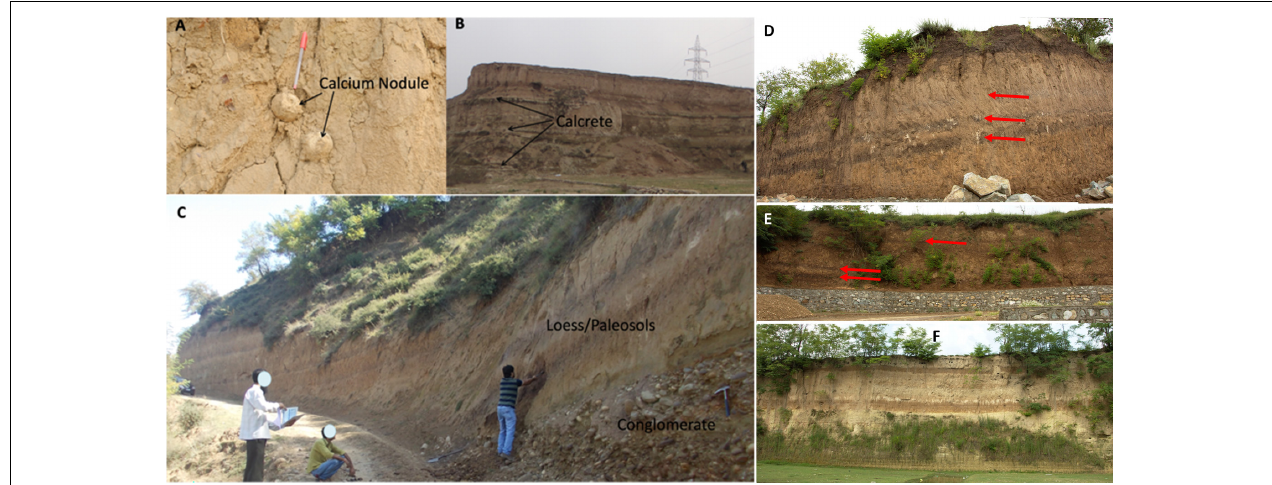
FIGURE 4 | Field photographs showing (A) calcium carbonate nodules in the 5th well developed palaeosol at the Shankerpora village section (C) , (B) three calcrete layers in lacustrine sediments near the town of Pampore underlying loess, reflecting dry and arid climatic conditions. These calcrete layers in Central Kashmir are chronologically and stratigraphically equivalent to the loess in the south-western Kashmir Valley (see Dar et al., 2015a for further explanation), (C) loess palaeosol sequence section near Shankerpora Village directly overlying the conglomerate bed of the Shopian Member of the Karewa Group. (D, E) Are images of the marker triplet, which is exposed in a road cut near Khan Sahib, in a plateau position (D) , and a slope position (E) . (F) Shows the loess overlying lacustrine deposits at Wanihama. The lower vegetated part of the wall shows clear layering of lacustrine